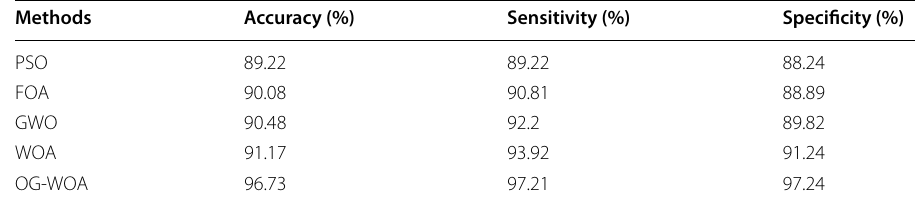
Table 5 Performance analysis of different optimization algorithm for feature selection on NWPU dataset